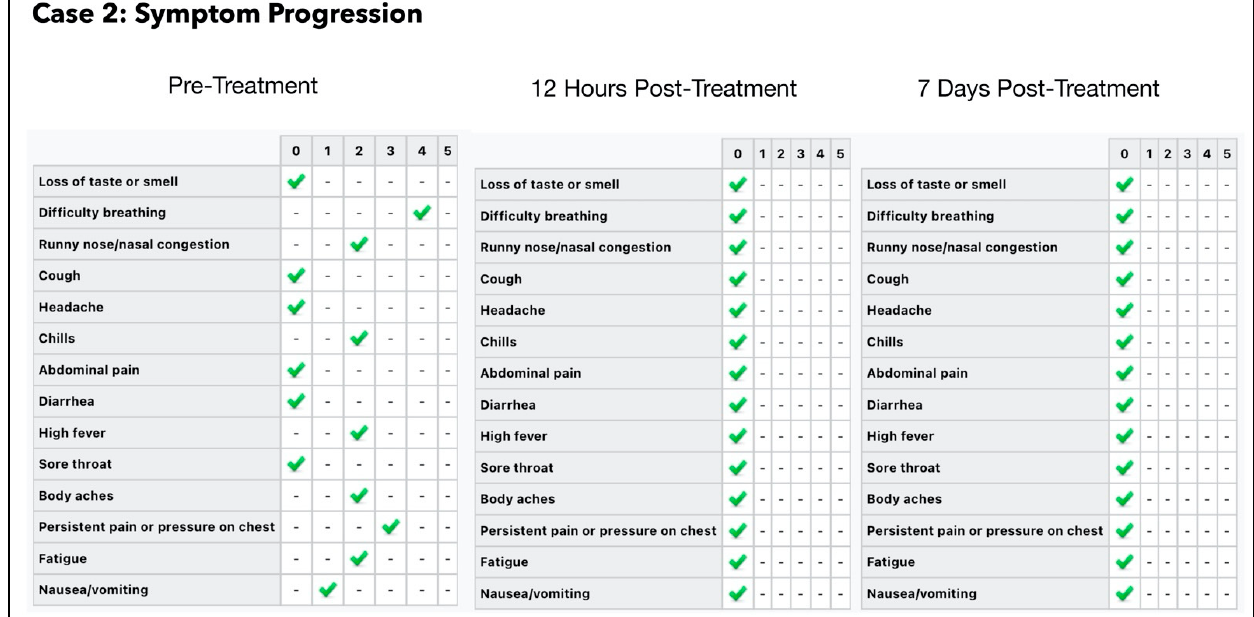
Figure 6. Shows symptom progression of subject